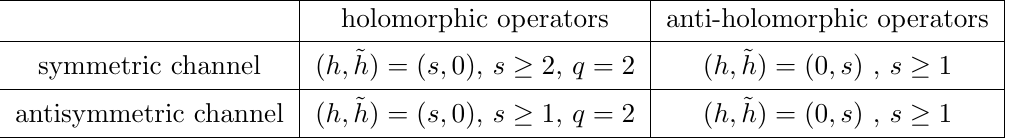
Table 2. The conserved operators in the limit